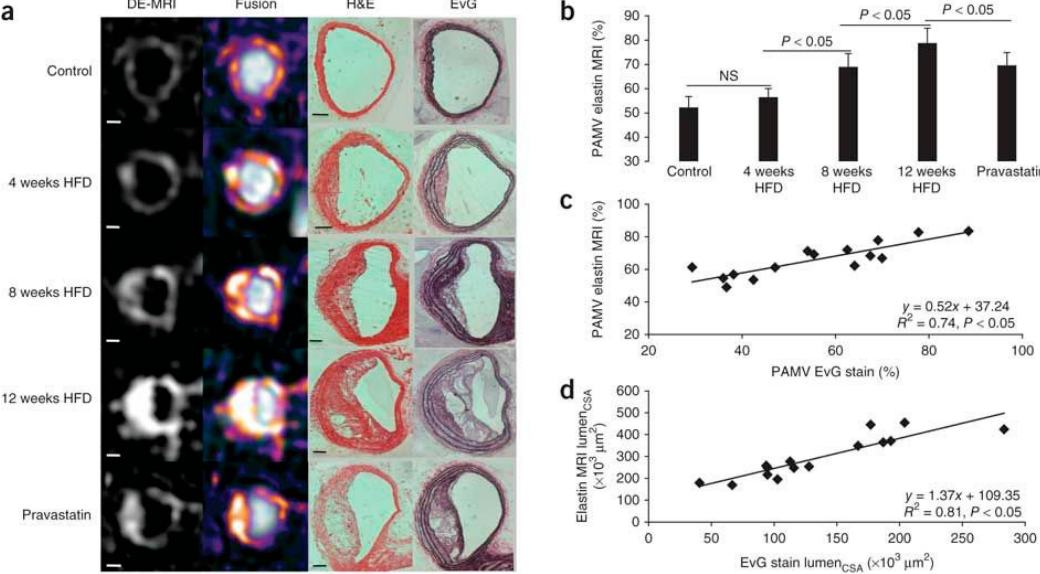
Figure 6. In vivo assessment of plaque burden by morphometric measurements. ( a ) Cross-sectional views of brachiocephalic arteries by MRI of control and ApoE − / − mice 4, 8 and 12 weeks after the onset of HFD (n = 8 per group). High-resolution delayed-enhancement images overlaid on TOF images with corresponding sections from histology (H&E and EvG stain). ( b ) Comparison of average PAMV, calculated from morphometric measurement on high-resolution DE images after the injection of ESMA (n = 8 per group). ( c , d ) Scatter plots showing significant ( p < 0.05) correlation between morphometric PAMV measurements ( c ) and lumen CSA measurements ( d ) on high-resolution DE-MRI (Delayed enhancement magnetic resonance imaging) images and on corresponding EvG-stained histological sections (n = 15). Scale bars: white, 250 μ m; black, 100 μ m. Values are expressed as means ± s.d. MRI—magnetic resonance imaging, HFD—high fat diet, TOF—time of flight, PAMV—percentage atheroma/media volume, CSA—cross-sectional area. Reproduced with permission from Makowski et al., 2011 [57].